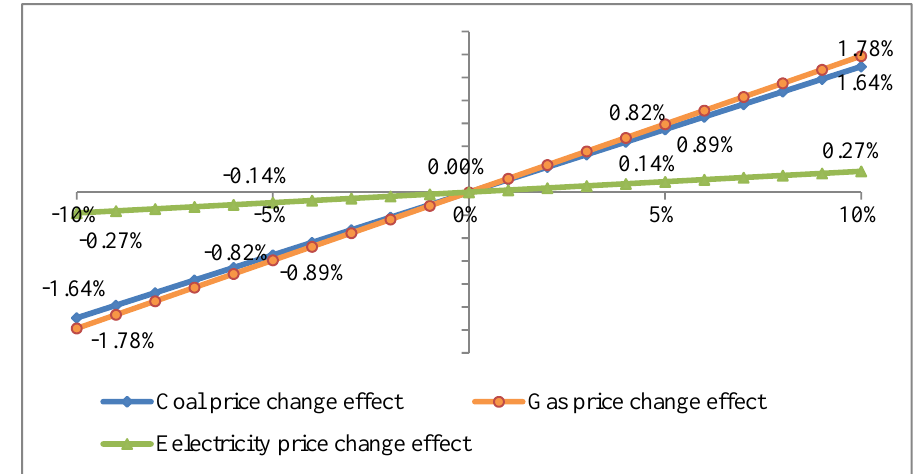
Figure 5. Annual changes in the cost of the central heating boiler under fluctuating coal prices.